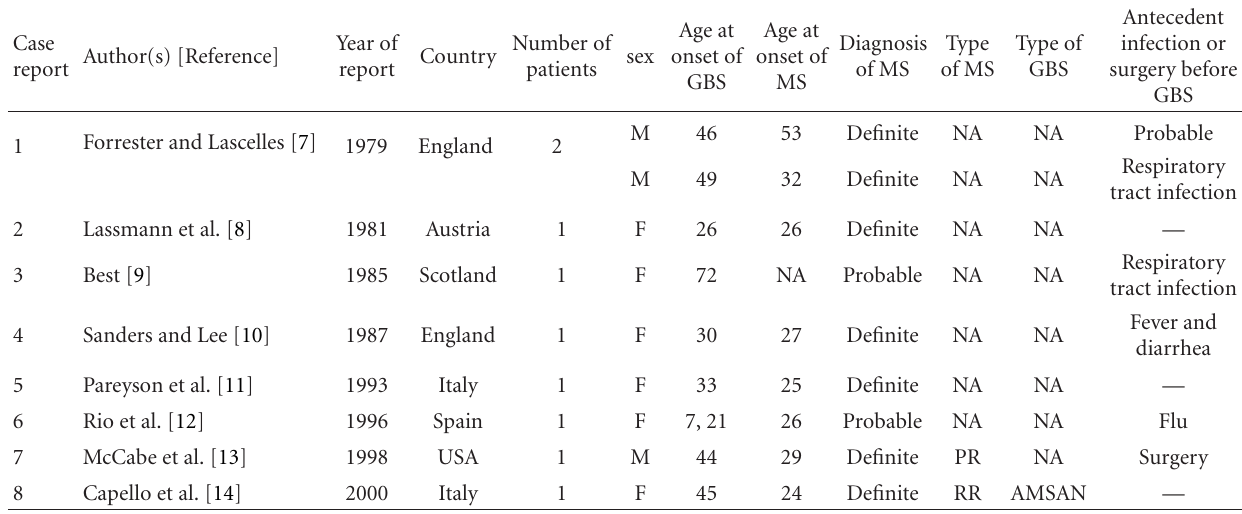
Table 3: Case report studies describing the co-existence of Guillain-Barre’ Syndrome and Multiple Sclerosis. Case